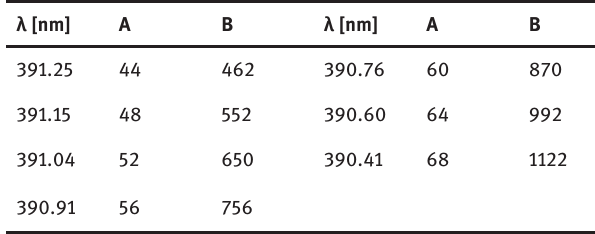
Table 4 : Lines from the P -branch of the 1 st negative system of the N 2+ and their characteristic parameters used to calculate the rotational